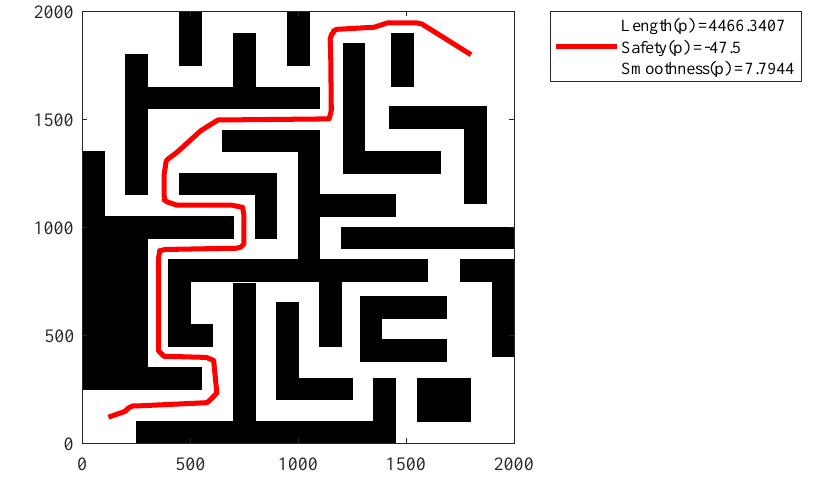
Figure 18. Graphical solution for the Figure 8E with